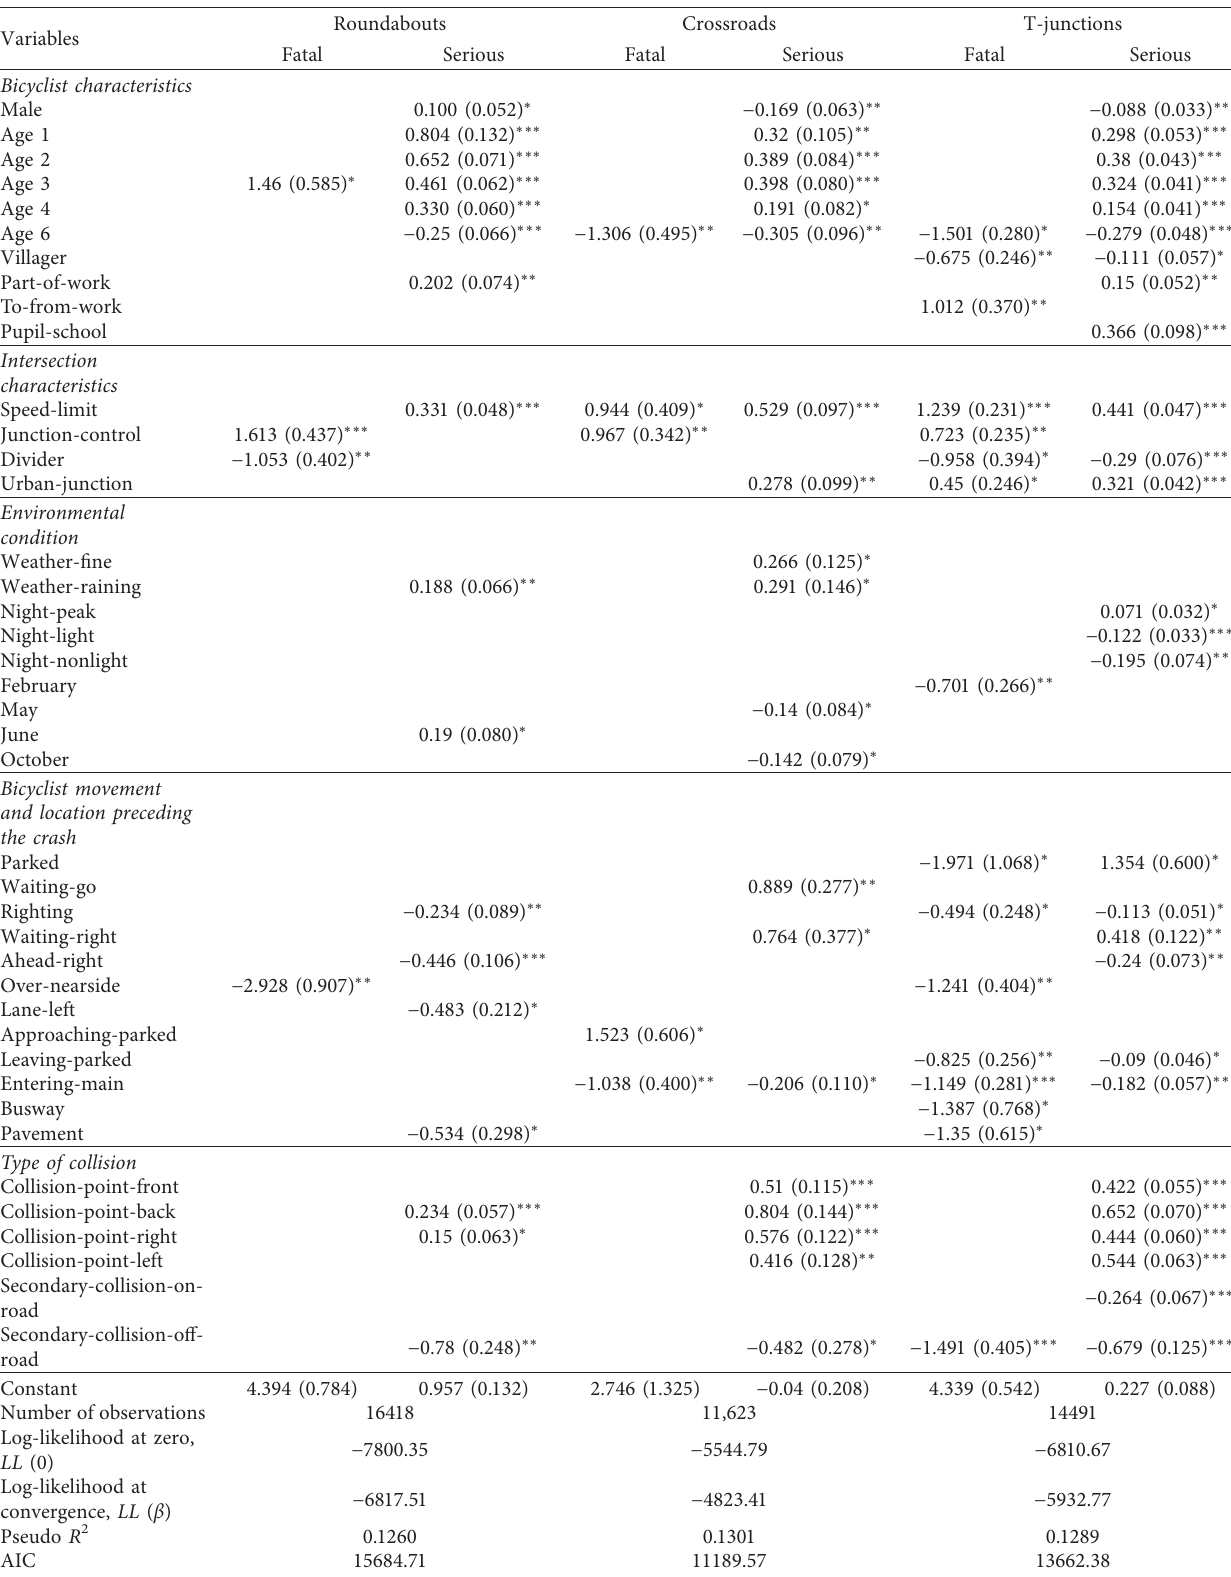
Table 3: Estimation results of the GOL